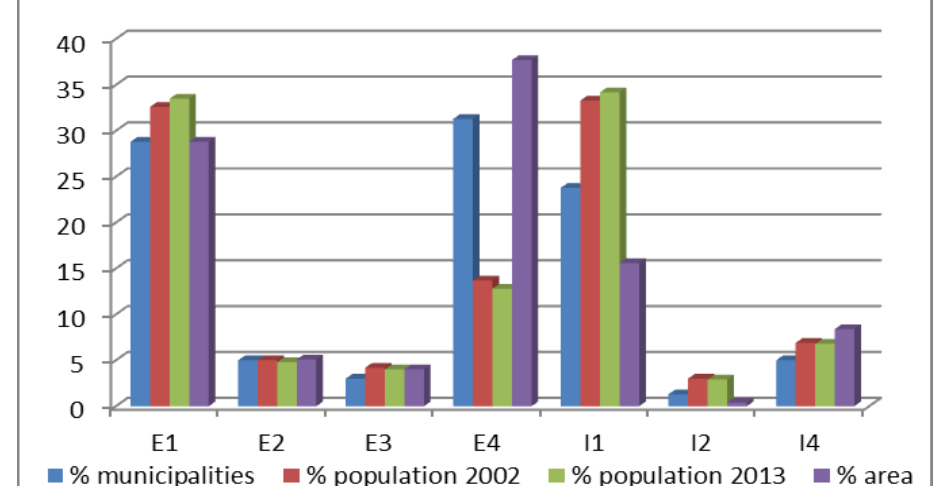
Fig. 3. Distribution of municipalities, population and area according to migration intensity in the period 2002-2013 (calculated by the authors, according to SSORM data)